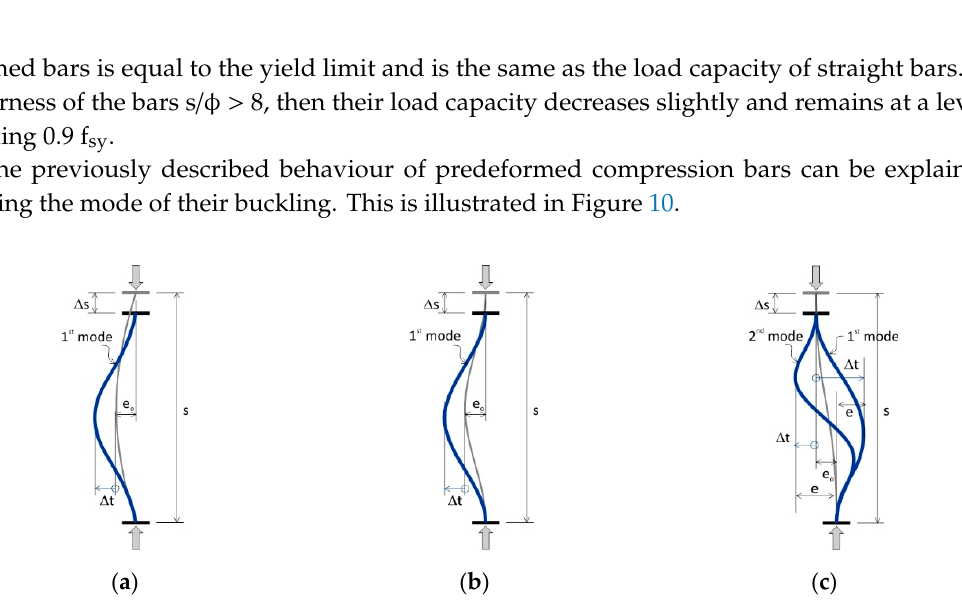
Figure 10. Mode of bars buckling: ( a ) bending deformation (MD), ( b ) compression deformation (ND) and ( c ) shear deformation (VD).